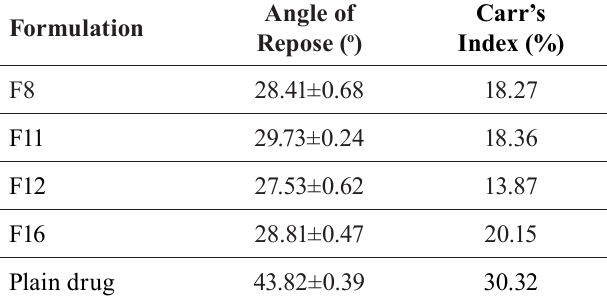
TABLE III - Flow properties of racecadotril liquisolid